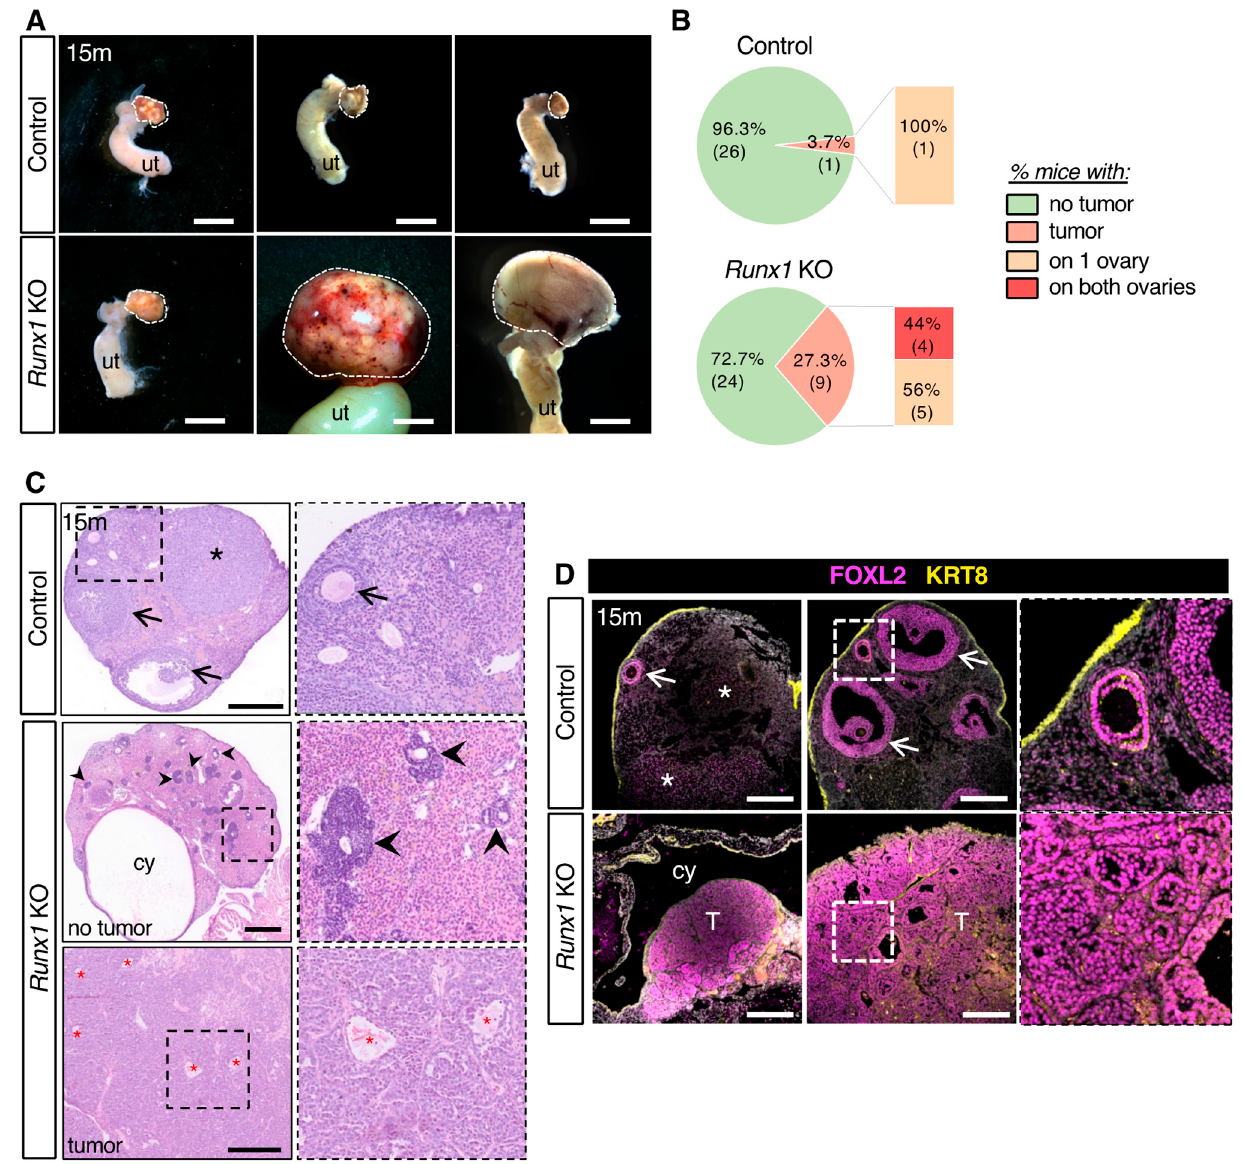
Figure 2 . Development of ovarian tumors in aged Runx1 knockout mice. ( A ) Macroscopic view of control and Runx1 KO ovaries at 15 months. White dotted lines outline the ovaries. ut represents uterus. Scale bar: 2.5 mm. ( B ) Percentage of mice with macroscopic ovarian tumors in control ( n = 27 mice) and KO mice ( n = 33 mice) at 15 months. The numbers in the parenthesis are the actual numbers of animals. ( C ) H&E-stained sections of representative 15-month control and Runx1 KO ovaries ( n = 8/genotype). Right panels are higher magnifications of outlined areas. Arrows indicate follicles; arrowheads indicate follicle-like lesions; the black asterisk indicates corpus luteum; Cy represents cyst; red asterisks indicate eosinophilic cavities. Scale bars: 300 μ m. ( D ) Immunofluorescence for FOXL2 (magenta) and KRT8 (yellow) in control ovaries and Runx1 KO ovarian tumors ( n = 4/genotype). Grey color represents nuclei labelled with DAPI. Right panels are higher magnifica- tions of outlined areas. Arrows indicate follicles; asterisks indicate corpora lutea; cy represents cyst; T represents tumor. Scale bars: 250 μ m.